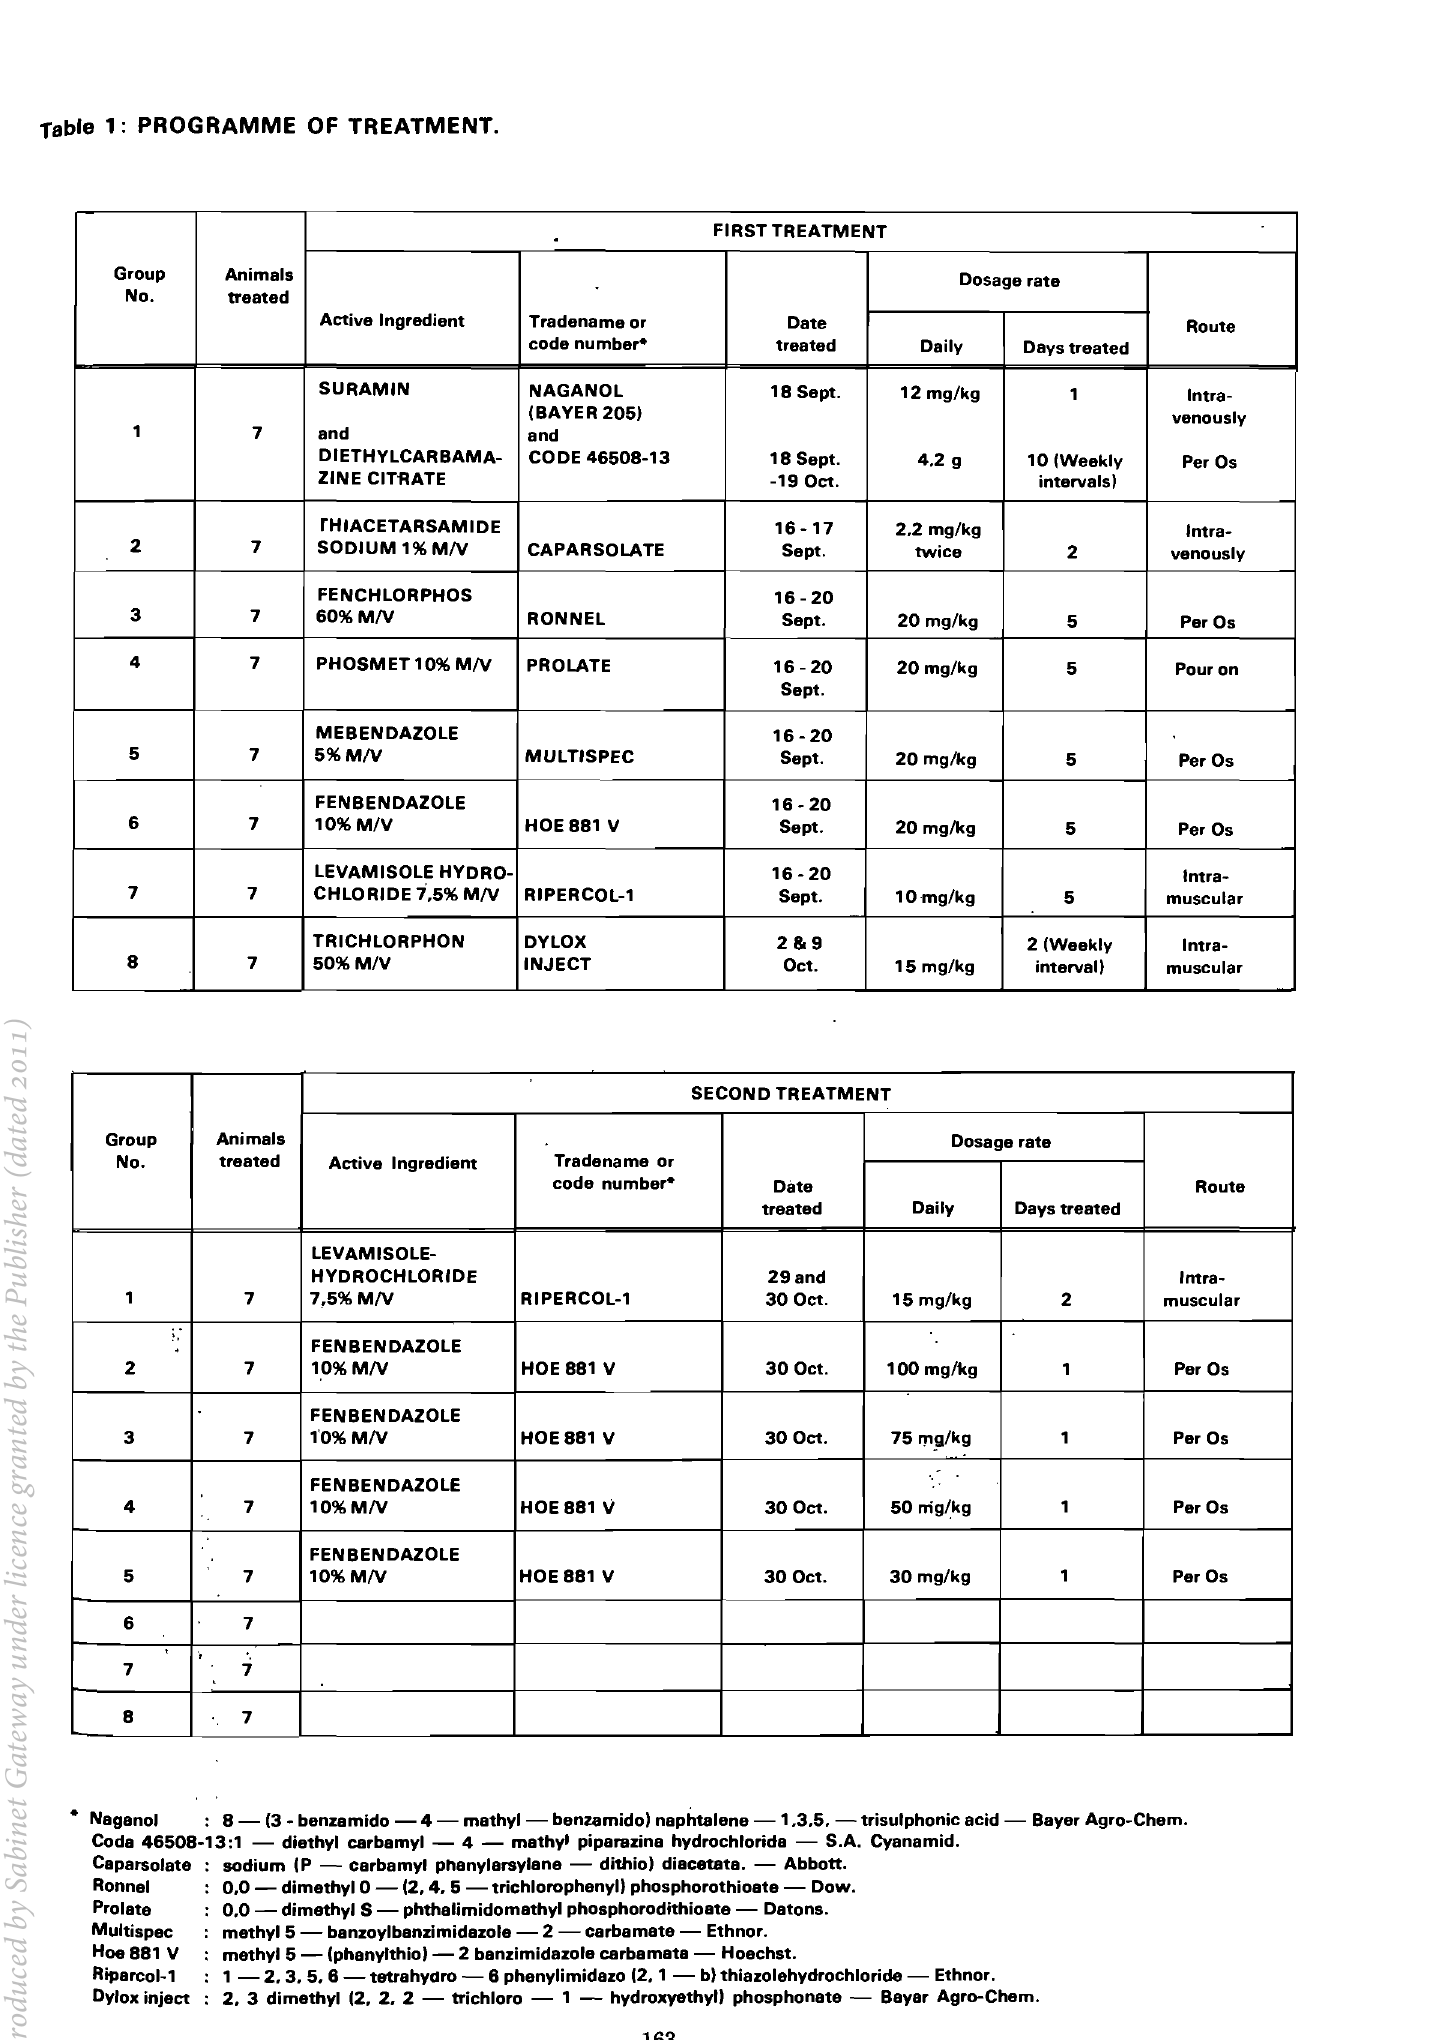
Table 1: PROGRAMME OF TREATMENT.